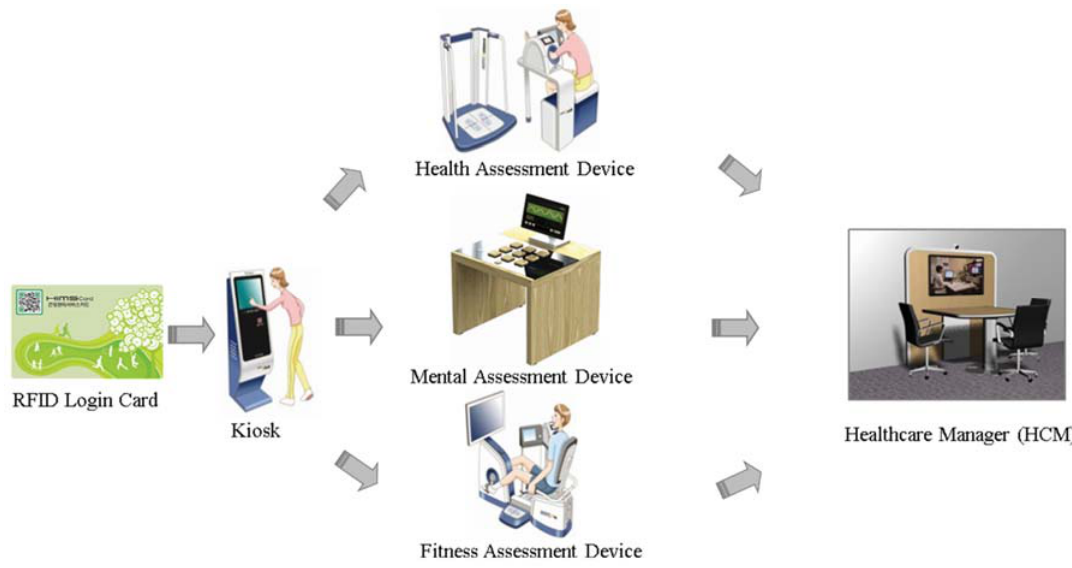
Figure 2. Typical flow of user accessibility to a U-Healthcare center. RFID: radio frequency identification.